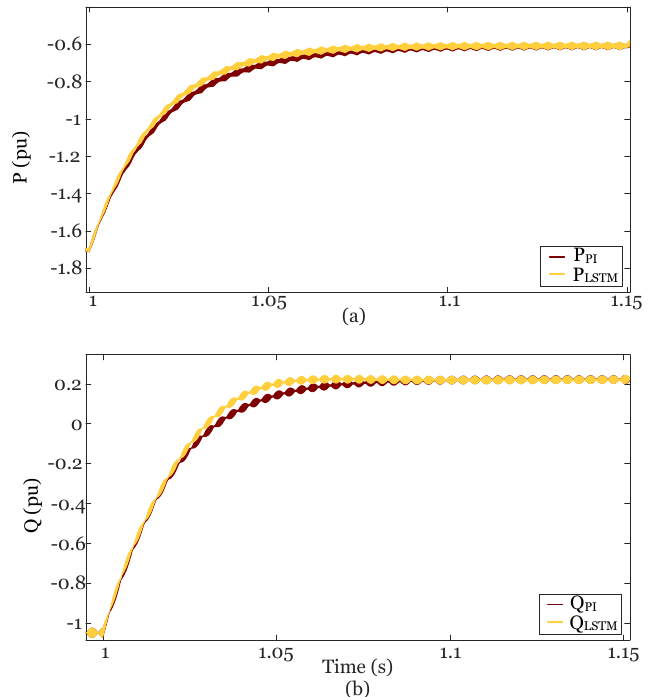
Figure 9. Real and reactive power response to step changes in i d , ref and i q , ref . ( a ) Real power; ( b ) Reactive power.